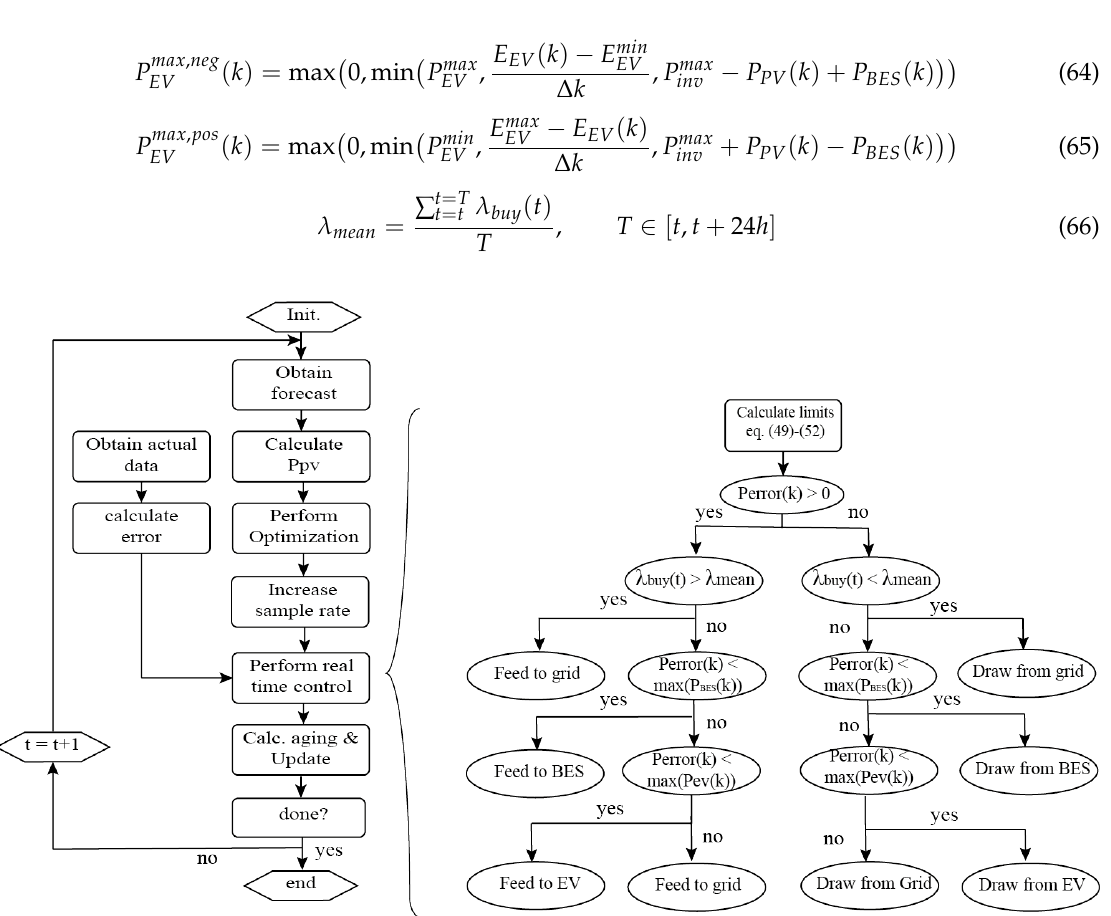
Figure 5. Moving horizon and real-time control